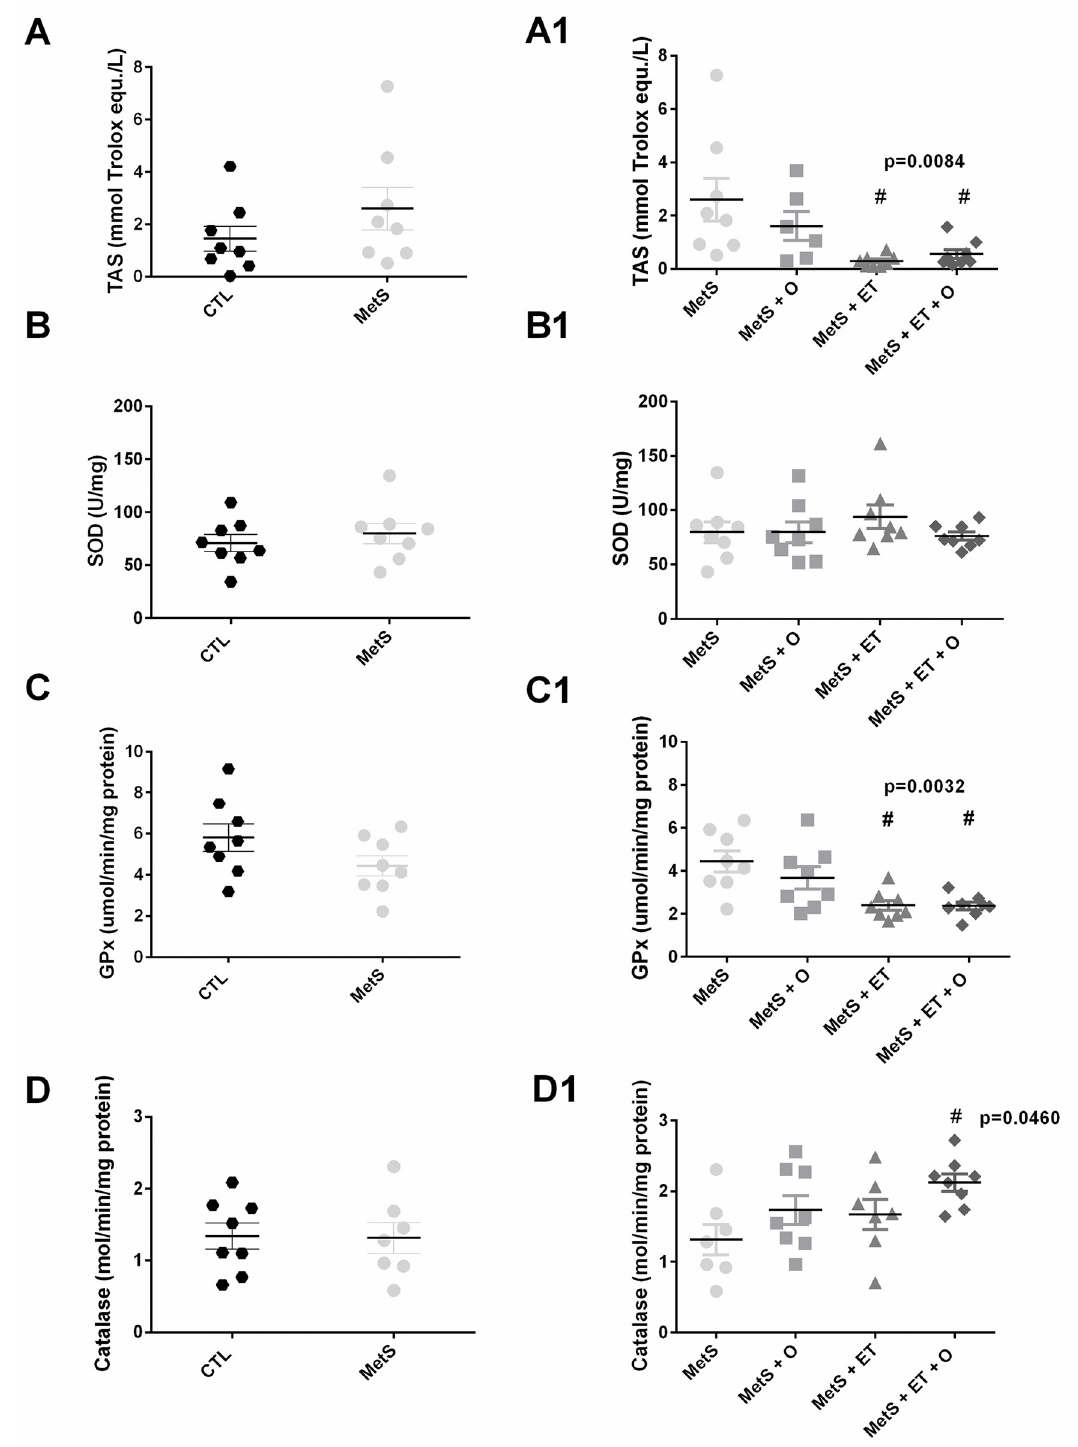
Fig 6. Analysis of antioxidative enzymes. (A/A1) TAS (p = 0.0084), (B/B1) SOD, (C/C1) GPx (p = 0.0032), (D/D1) Catalase (p = 0.0460). #vs. MetS. Statistic: One-Way ANOVA, p < 0.05.